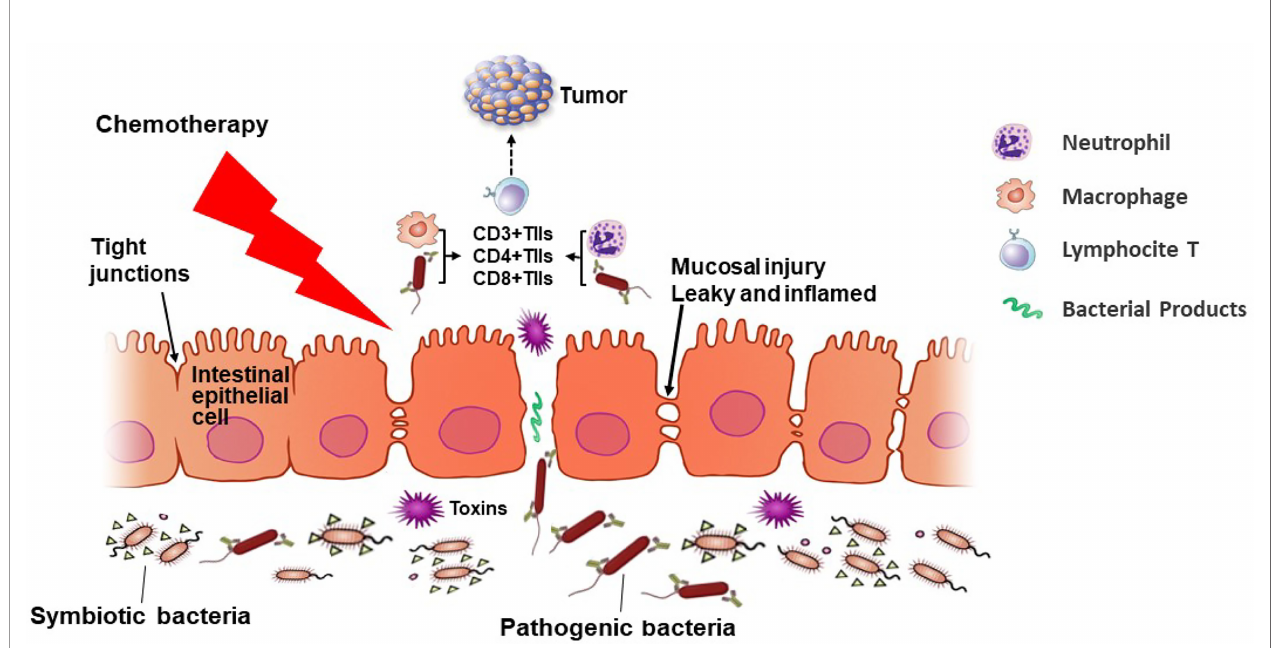
FIGURE 8 | An overview of the microbiota – T lymphocyte (TILs) interactions that modulate neoadjuvant chemotherapy (NAC) ef fi cacy. NAC treatment induces changes in the gut microbiota diversity, causing in fl ammation and damage to the mucosal barrier of cancer patients, permitting pathogenic bacteria to cross the intestinal barrier and enter lymphoid organs. Then the intestinal microbiota may mediate the induction of TILs such as CD3 + , CD4 + , and CD8 + cells in patients undergoing NAC. When the tight junctions between epithelial cells are broken and the intestinal permeability reduces, pathogenic bacteria interact with immune cells, regulating the response rate of the NAC